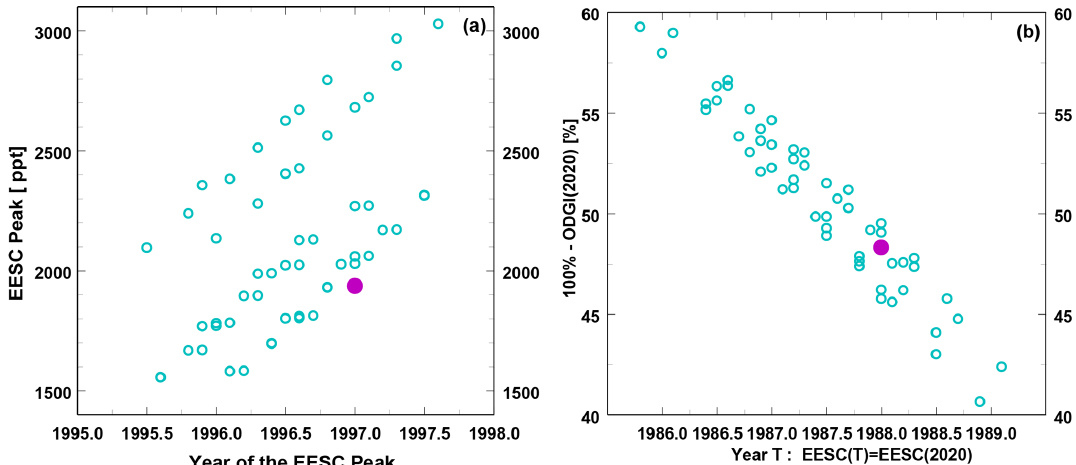
Figure 3. The EESC characteristics derived via the Goddard automailer (open circles) and those (full circles) taken from Montzka et al. (2022): EESC maximum value versus the year at the peak (a) , ORI 2 (1997,2020) value calculated on the basis of the EESC values in Eq. (2) (equivalent to 100%–ODGI(2020)) versus the year when the EESC value is equal to that in 2020 (b) .